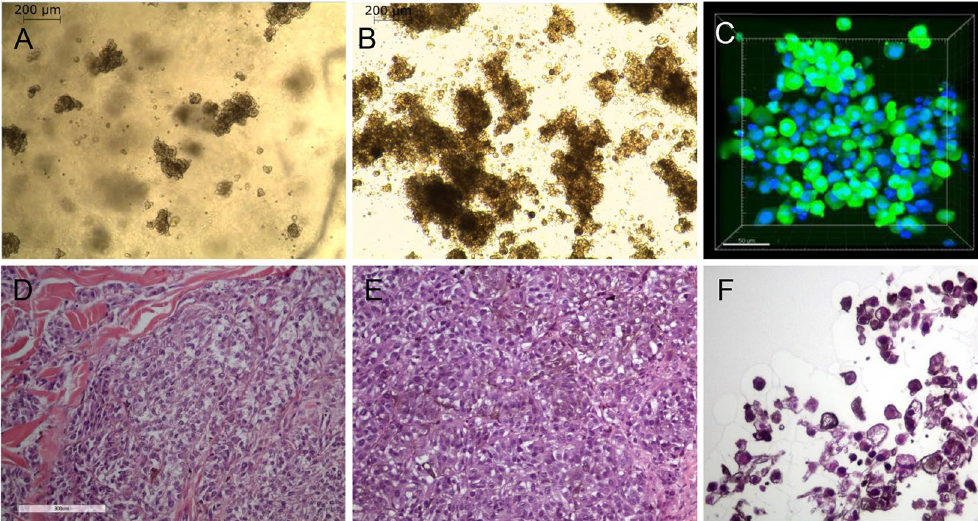
Figure 5. Morphology of MUG-Mel2 in 3D cultures. Cells formed spheroids in nanofibrillar cellulose (NFC) after two days in a concentration of 0.4% ( A : 50x magnification), after five days in a concentration of 0.4% ( B : 50x magnification); intensive brown staining was observed. Calcein staining (green) revealed the viability of the spheroids, nuclei were counterstained with DAPI (blue) ( C ). HE staining of human tumor tissue ( D ), tumor xenotransplantat ( E ), and 3D culture of MUG-Mel2 cells showed typical melanoma morphology and pigmented cytoplasm ( F ).